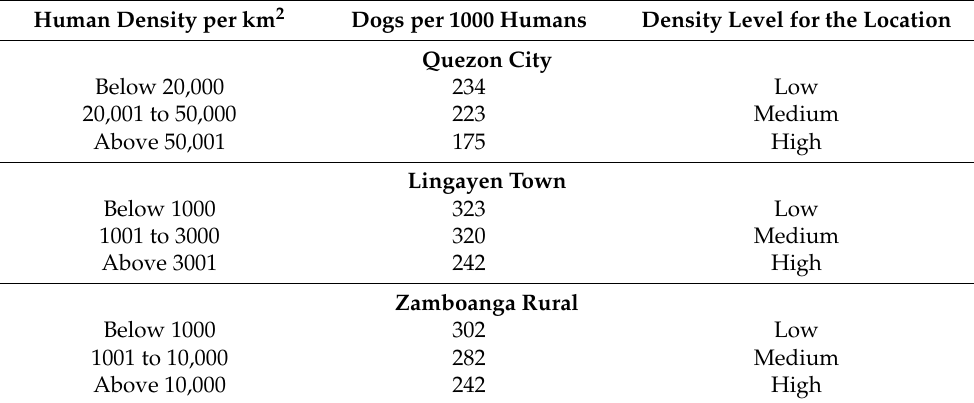
Table 3. Dogs per 1000 humans based on the density of the human population in Quezon City, Lingayen town and Zamboanga rural Each location was divided into three density categories (low, medium and high).